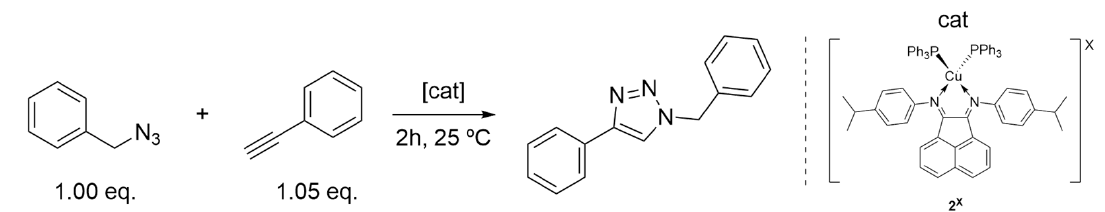
Scheme 3. Reaction conditions of solvent screening using model substrates, benzyl azide and phenylacetylene, and catalysts 2 X .